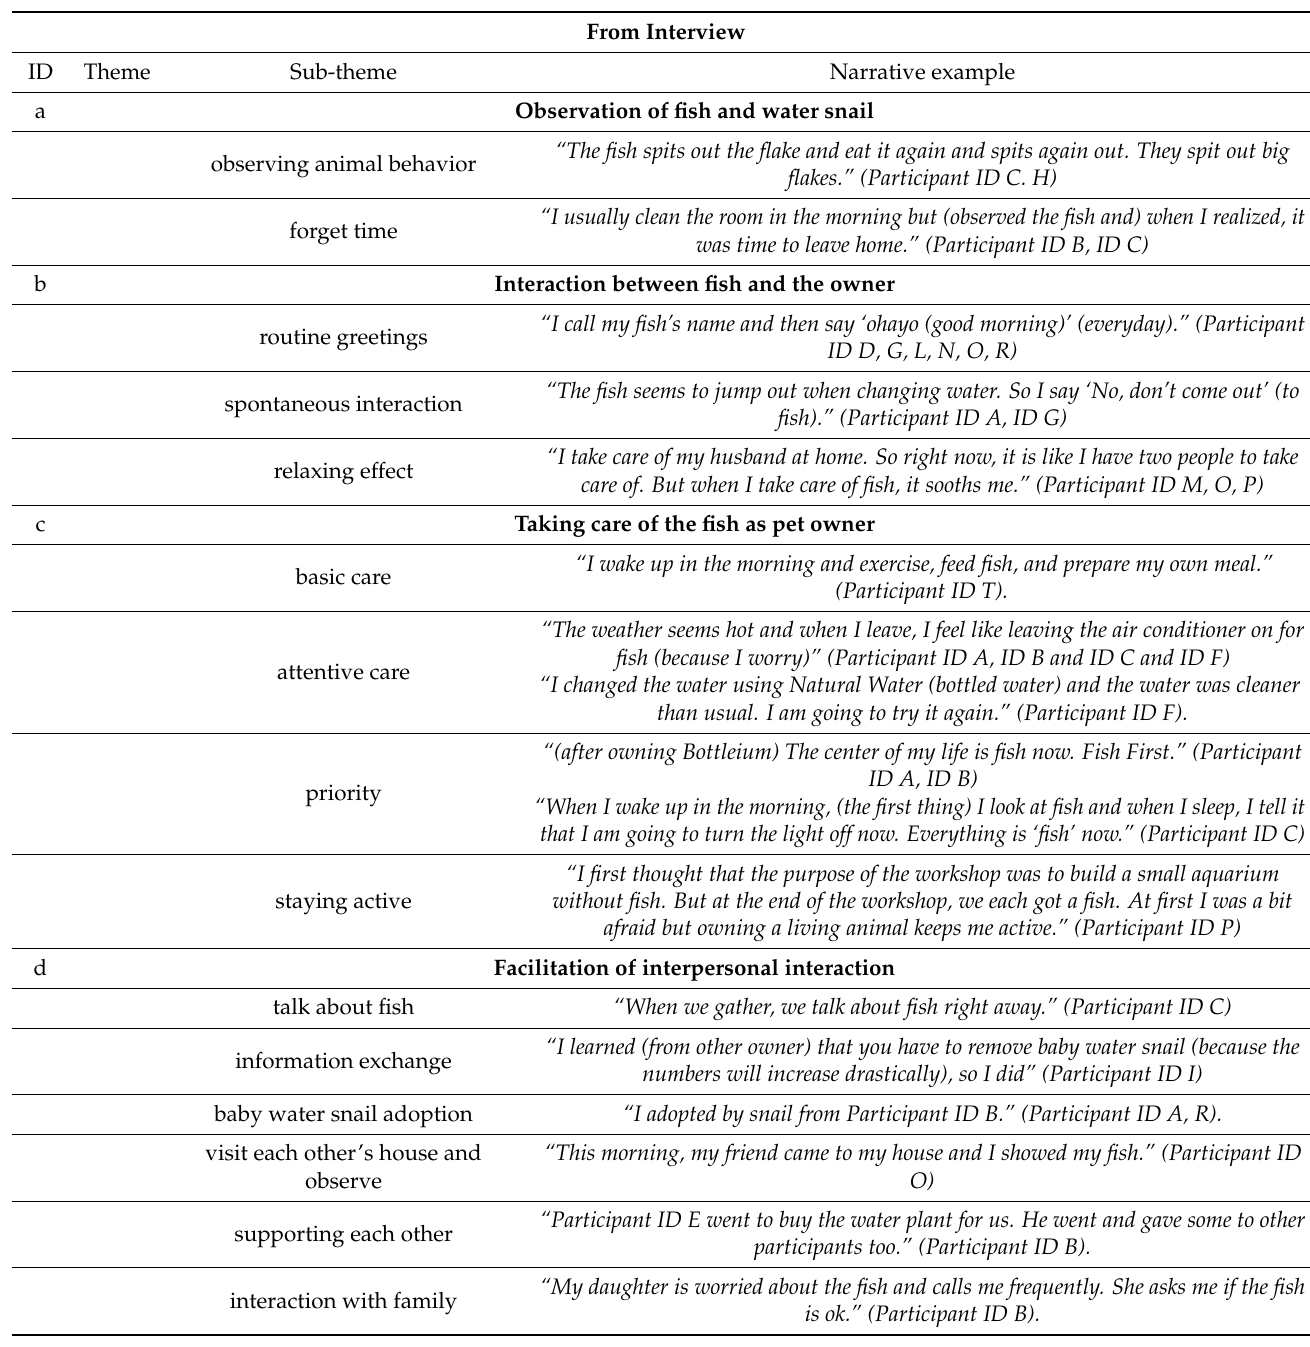
Table 2. Themes and Narrative Sample from Interview and Observational Research. The first ID is the actual speaker of the narrative, and the following IDs are participants who spoke similar